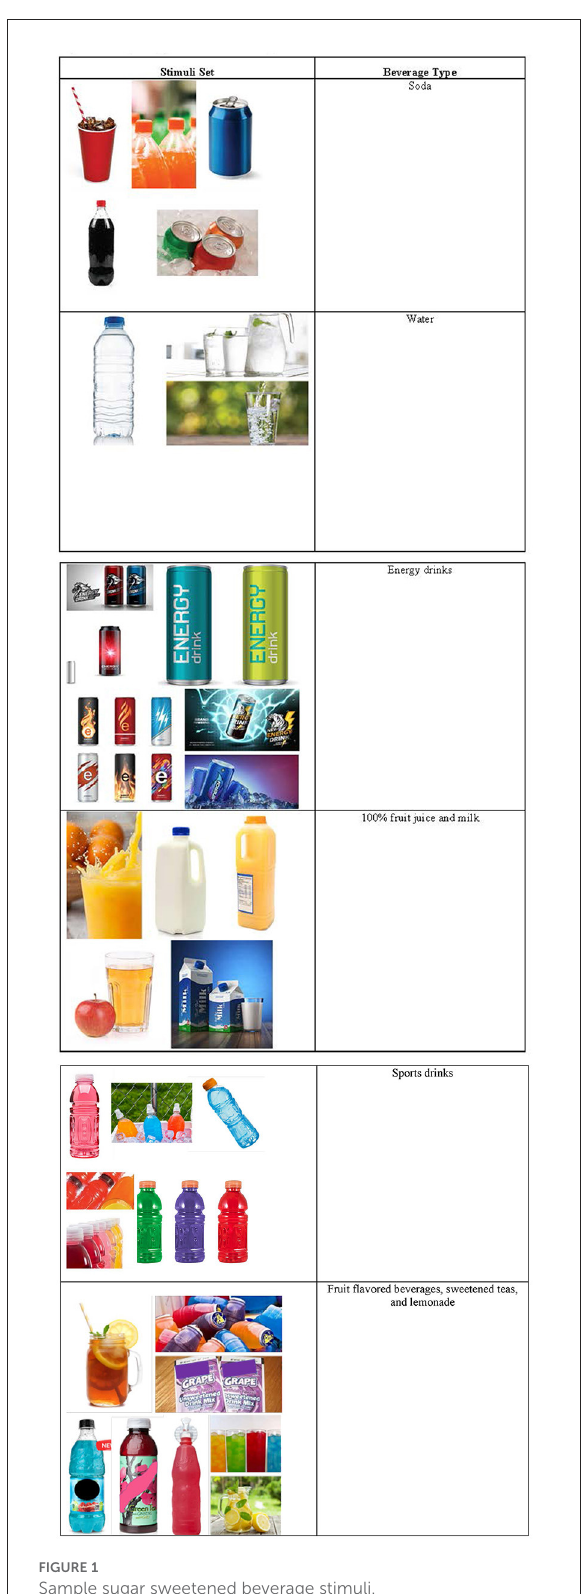
FIGURE1 Sample sugar sweetened beverage